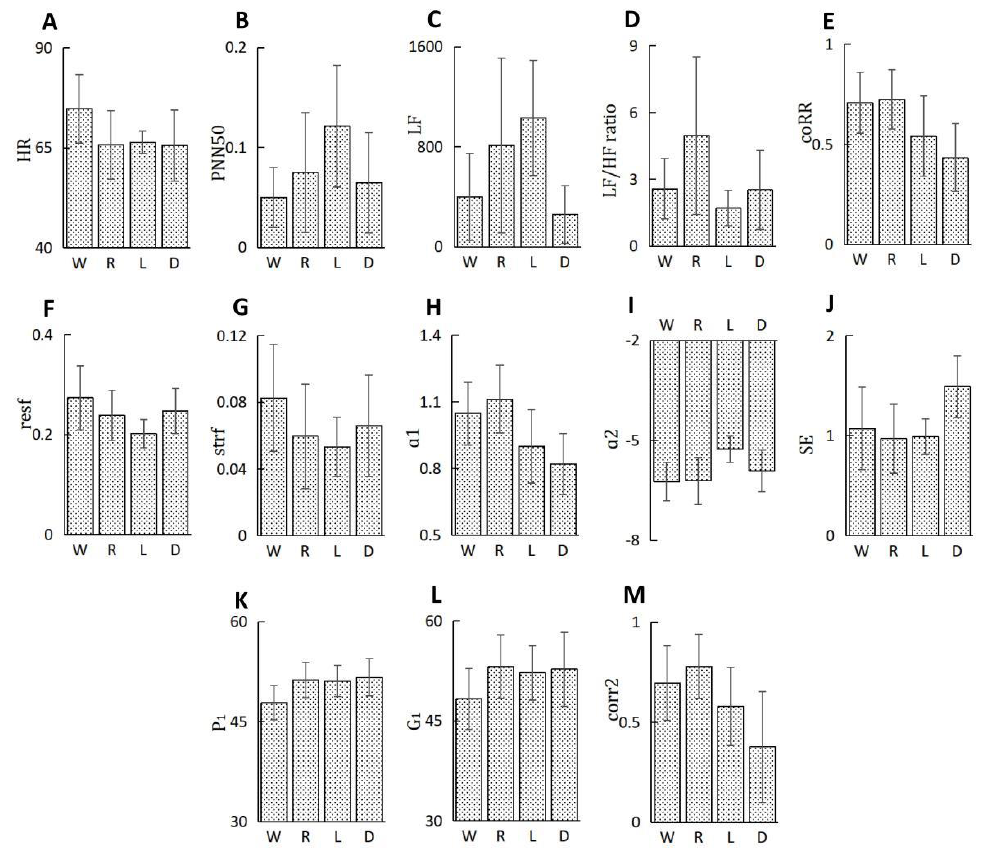
Figure 5. ( A – M ) show the statistical difference of the features we select in different sleep stages. (“W”,” R”,”L”,”D” are the abbreviation of wakefulness stage, REM stage, light sleep (N1&N2) and deep sleep (N3) respectively. Aesthetically, the vertical axis representing α 2 is plotted in reverse order).